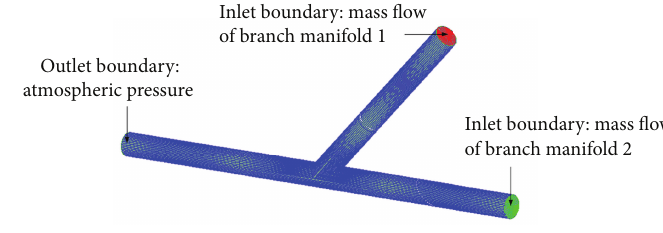
Figure 12: Simulation model of junction.